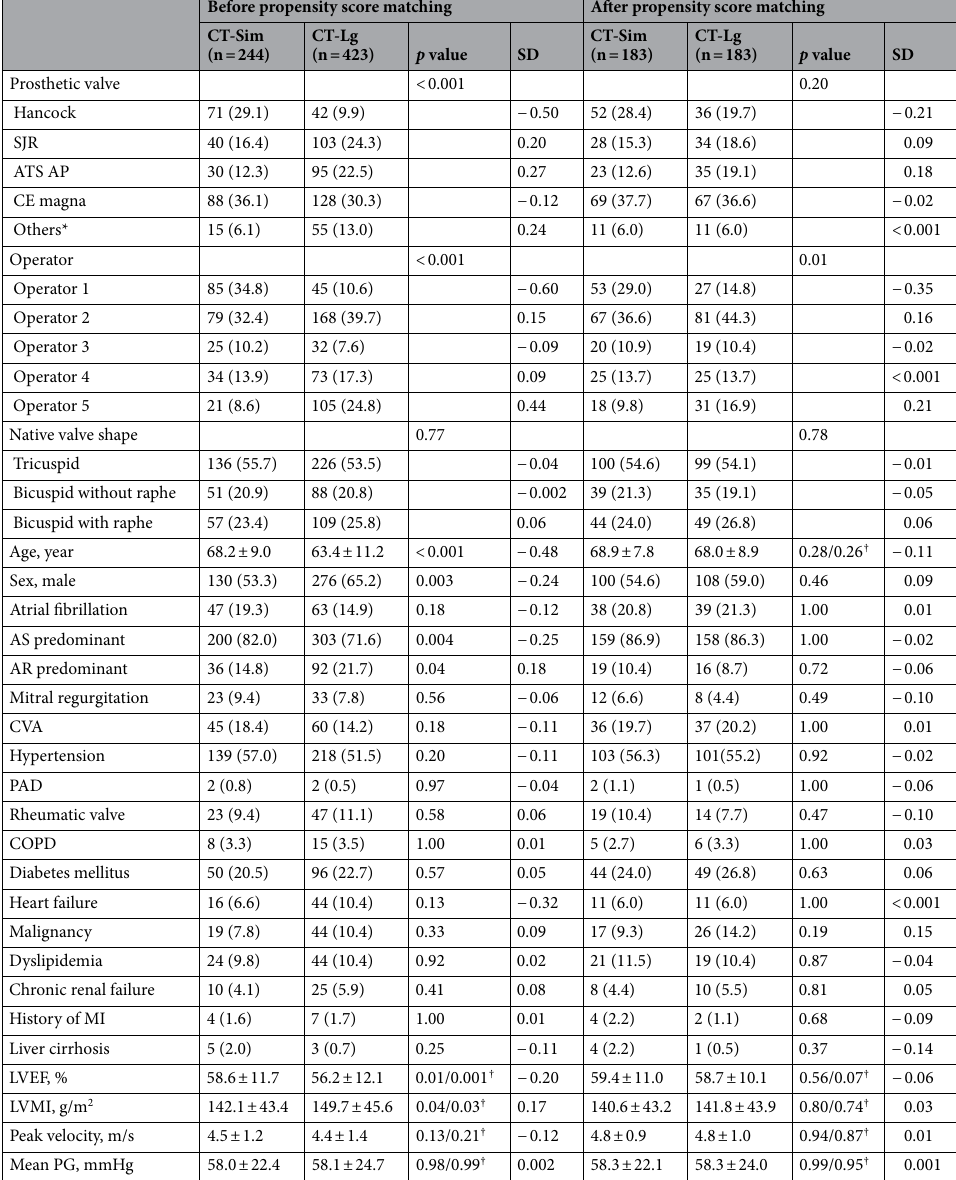
Table 4. Comparison between patients with > 10% larger diameter on CT from the surgical aortic valve size (CT-Lg, n = 423) and those ≤ 10% range (CT-Sim, n = 244), before and after applying propensity scores. Data are shown as the number of patients with percentages in parentheses or mean ± standard deviation unless specified otherwise. When the continuous variables do not follow the normal distribution, t -test result assuming the normality and the Shapiro–Wilk Test indicating the non-normal test are specified in the p -value ( p -value in t-test/ p -value in Shapiro–Wilk test) † . *Valves including Sorin (n = 24), On-X (n = 12), CM TopHat (n = 11), Trifecta (n = 11), Mitroflow (n = 8), Mosaic (n = 3) and Biocor (n = 1). AR, aortic regurgitation; AS, aortic stenosis; CE magna, Carpentier-Edwards PERIMOUNT Magna; COPD, chronic obstructive pulmonary diseases; CVA, cerebrovascular accident; LVEF, left ventricular ejection fraction; LVMI, left ventricular mass index; MI, myocardial infarction; PAD, peripheral arterial disease; PG, pressure gradient; SD, standard deviation; SJR, St Jude Medical